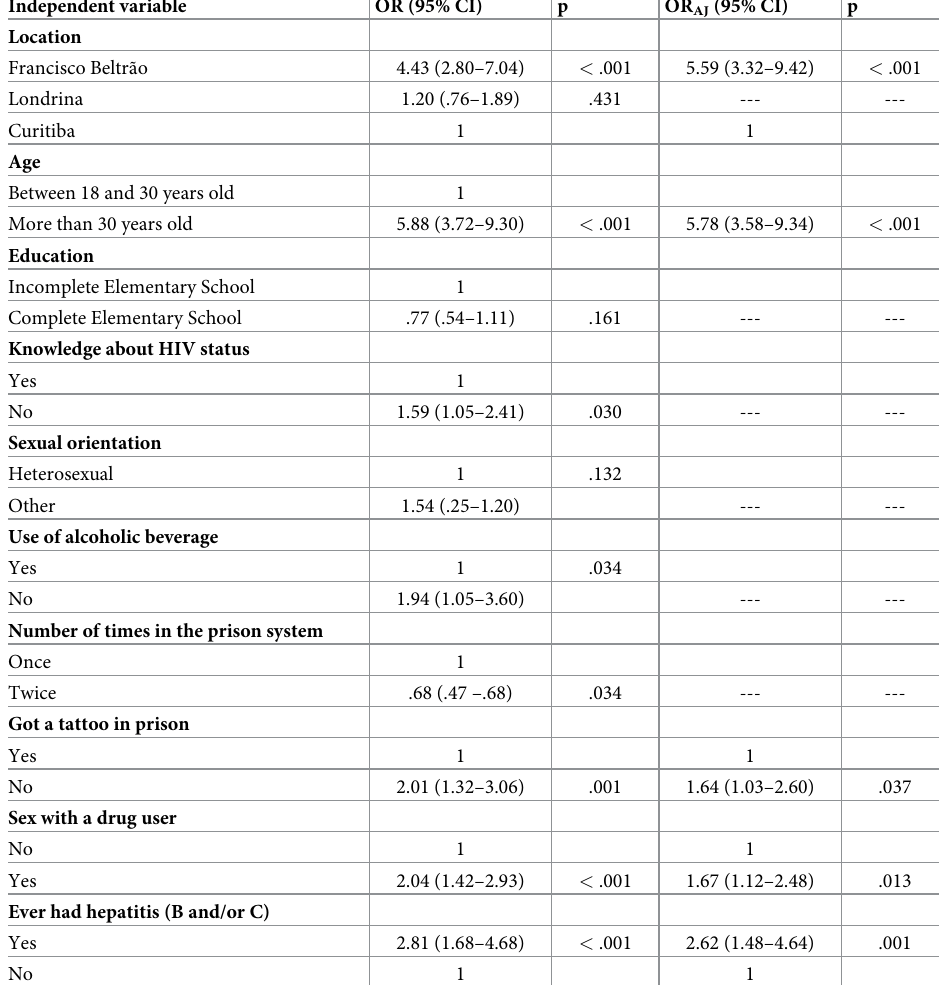
Table 2. Factors associated with hepatitis B seroprevalence in eleven state penitentiaries in three cities of Parana´,